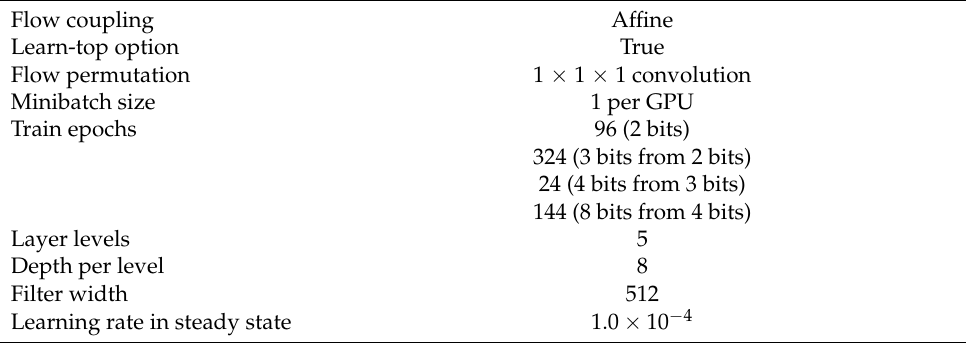
Table 1. Hyperparameters used to train 3D GLOW